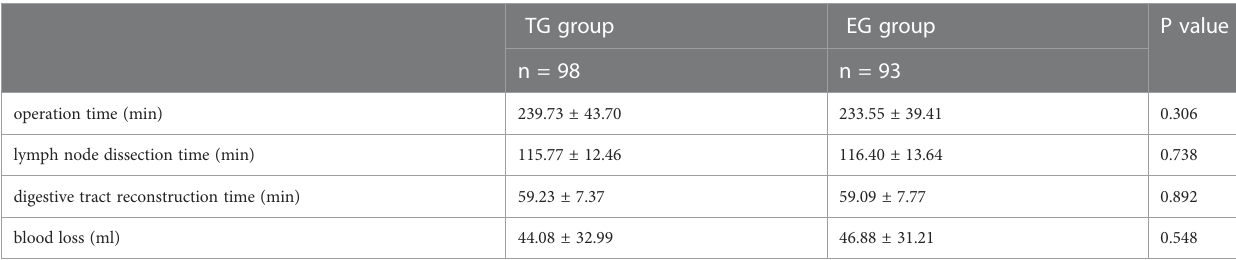
TABLE 2 Intraoperative